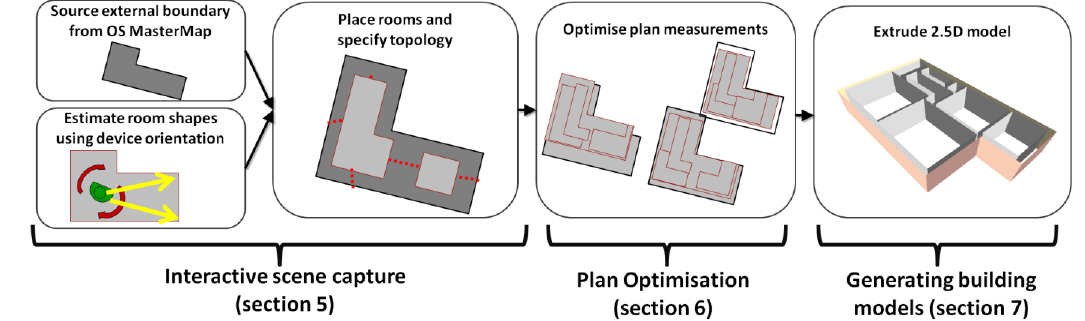
Figure 1. System overview and associated paper sections.